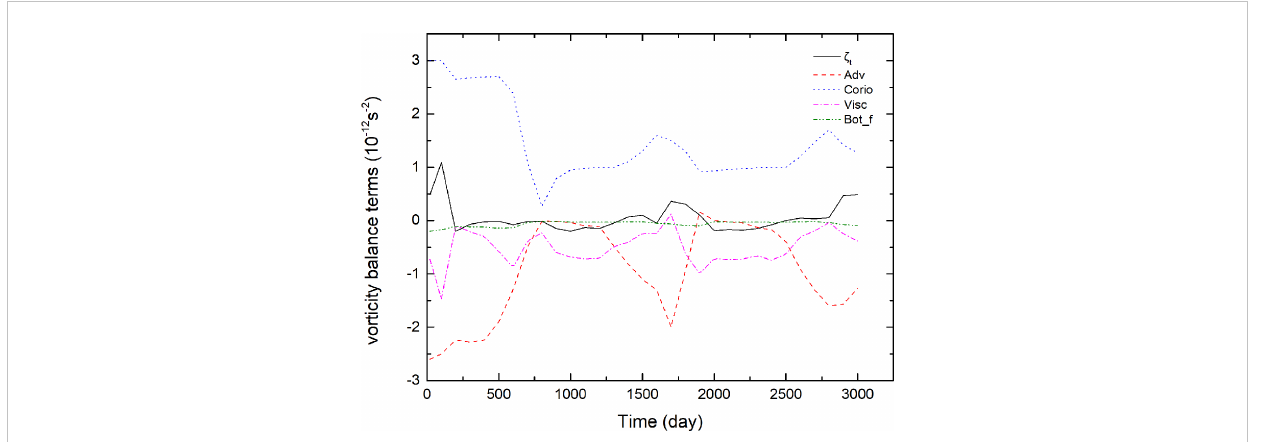
FIGURE 10 Time evolution of the vorticity balance terms near X P during the interaction between a cyclonic eddy with the WBC critical from leap to penetration at Re = 44 in the vicinity of the gap with two islands. WBC, western boundary current.